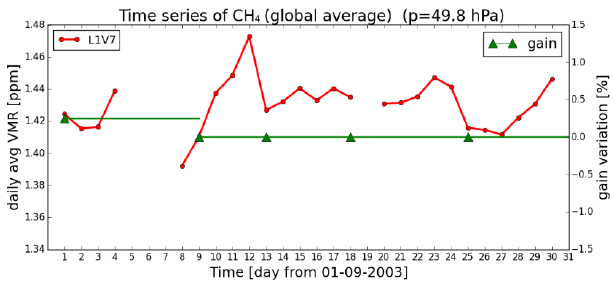
Figure 24. Time series of CH 4 global average at pressure 49.8hPa relative to September 2003 derived from L2 V7 MIPAS data (red line) and the used gain function (green line), with the triangles indi- cating the days at which the gain function has been updated.